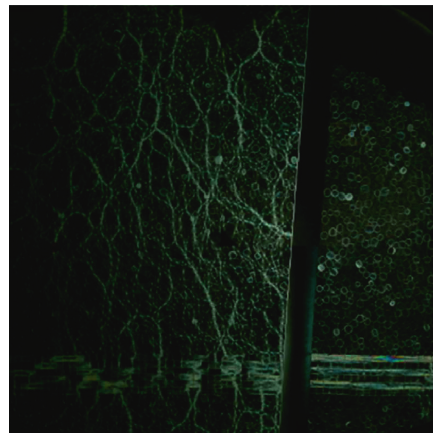
Figure 7: Force chains after the first excavation.